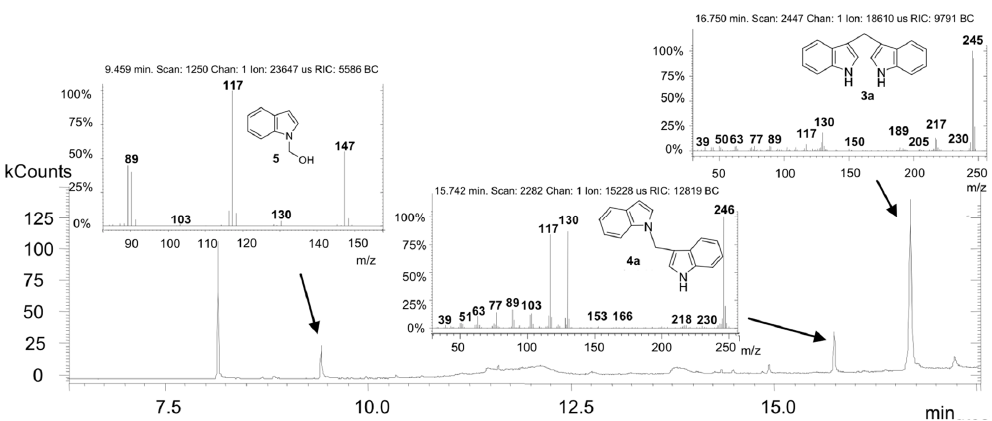
Figure 1. Gas chromatogram (GC) and mass spectra of compounds 3a , 4a and 5 .